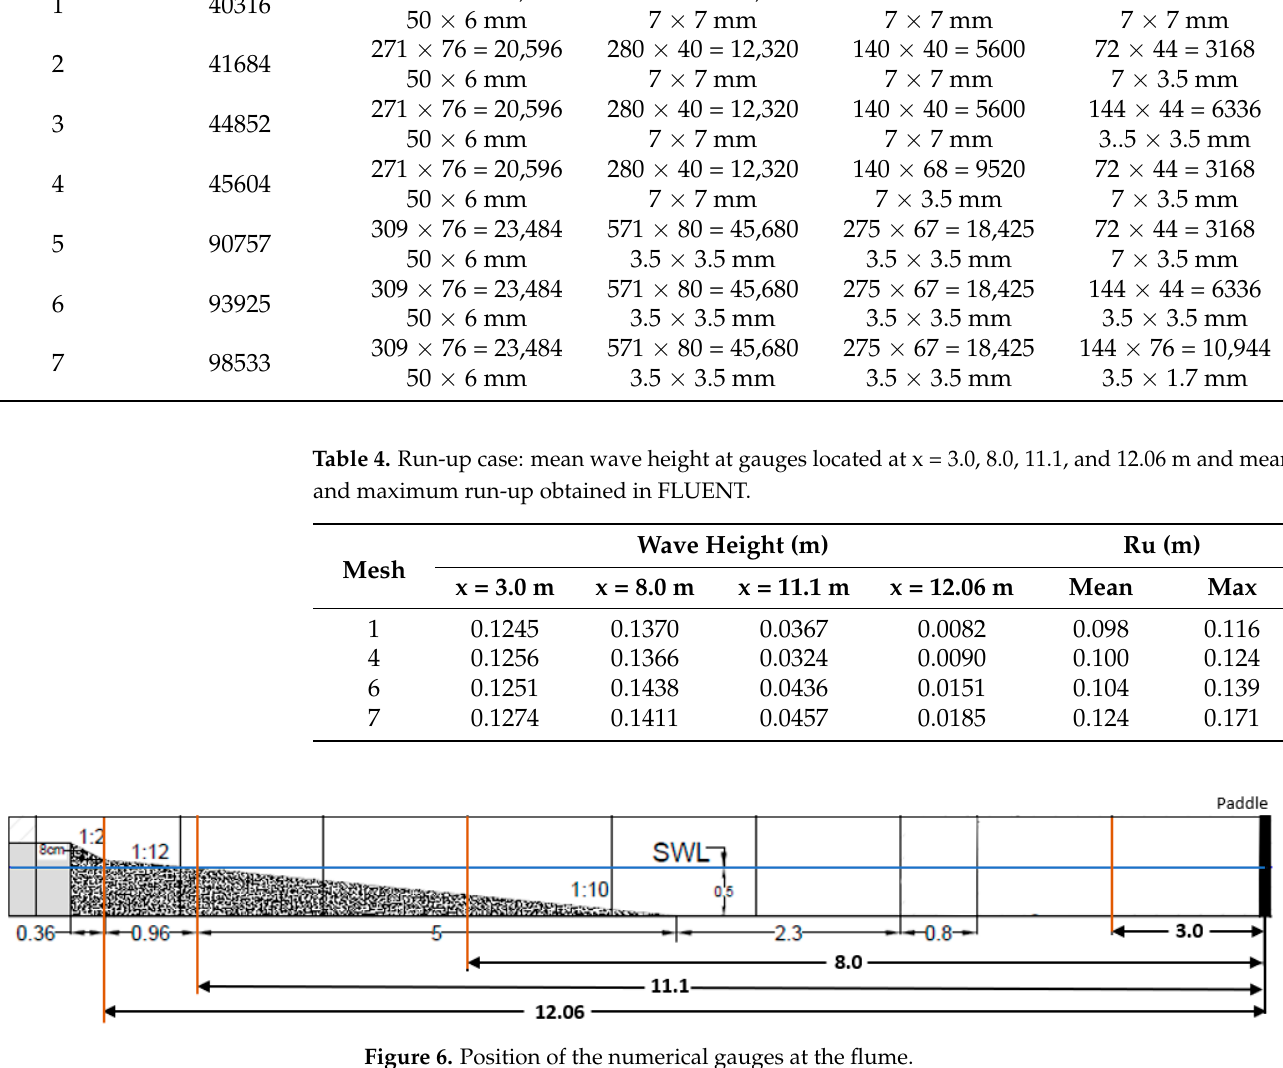
Figure 6. Position of the numerical gauges at the flume.